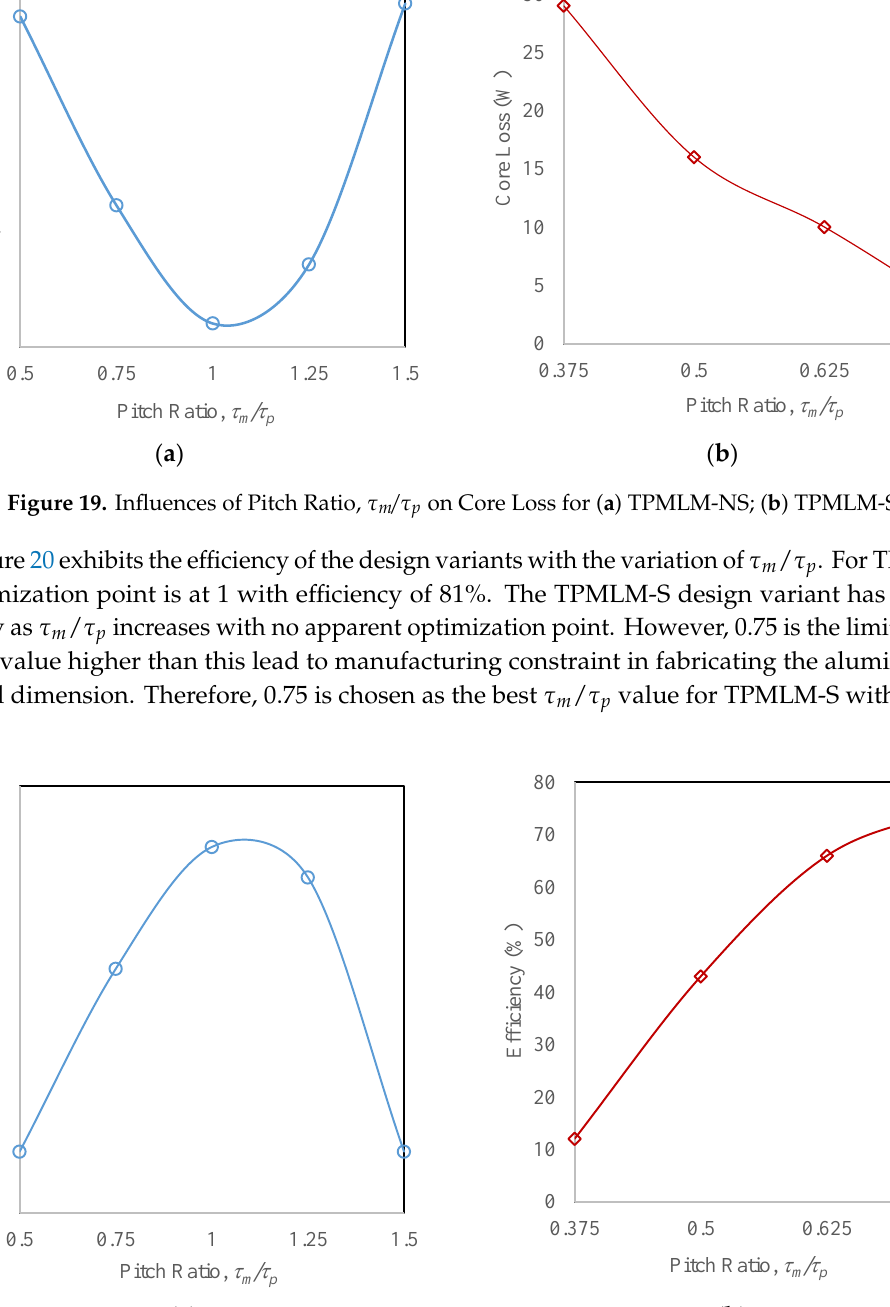
Figure 20. Influences of Pitch Ratio, τ m / τ p on Efficiency for Design with Spacer, ( a ) TPMLM-NS; ( b ) TPMLM-S.